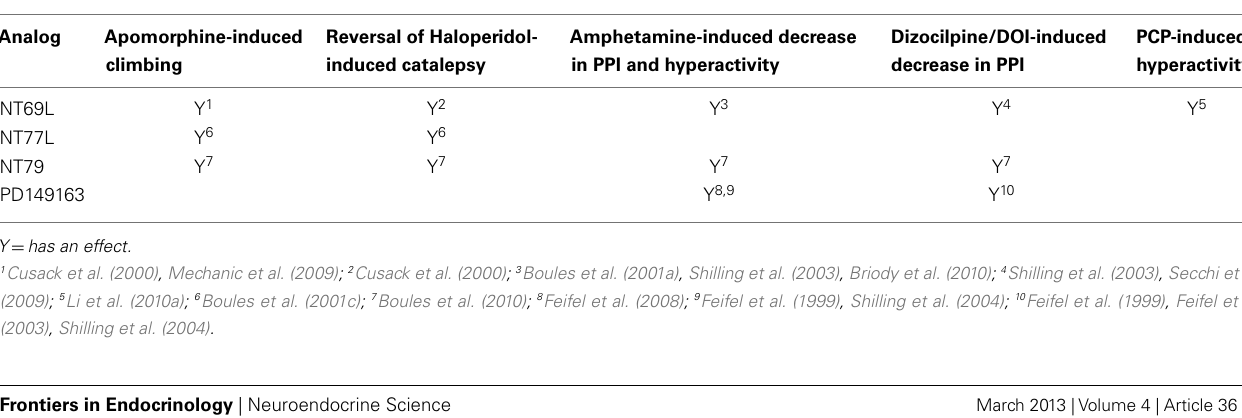
Table 2 |Antipsychotic effects of NT